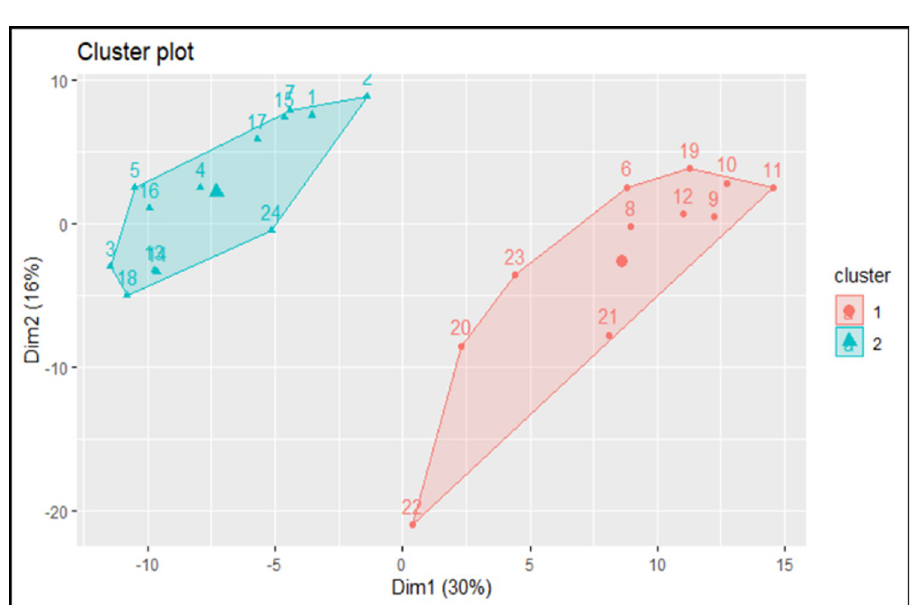
Fig 6. Cluster analysis of L vs CTRL comparison. Numbers represent the pigs sampled and different colours indicate the clusters. Cluster 1 = CTRL; Cluster 2 = L. https://doi.org/10.1371/journal.pone.0264953.g006 significantly correlated and discriminating the two diets (S6 Table). The 14 DEGs were only present in this comparison, while among the lipids only 4 are exclusive in this comparison and 32 have also been found between L+P vs . CTRL. Some genes correlate with more than one lipid for a total of 85 significant correlations, of which 65 were negative and 20 positive. Those genes showing an r value > 0.6 or < -0.6 and having a significant p are listed in Table 3. The lipid classes establishing a high number of correlations were predominantly